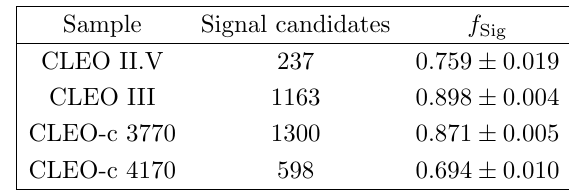
Table 2 . Updated number of signal candidates and fractions in the signal region, for (cid:13)avor-tagged D 0 ! K + K (cid:0) (cid:25) + (cid:25) (cid:0) data in the di(cid:11)erent CLEO